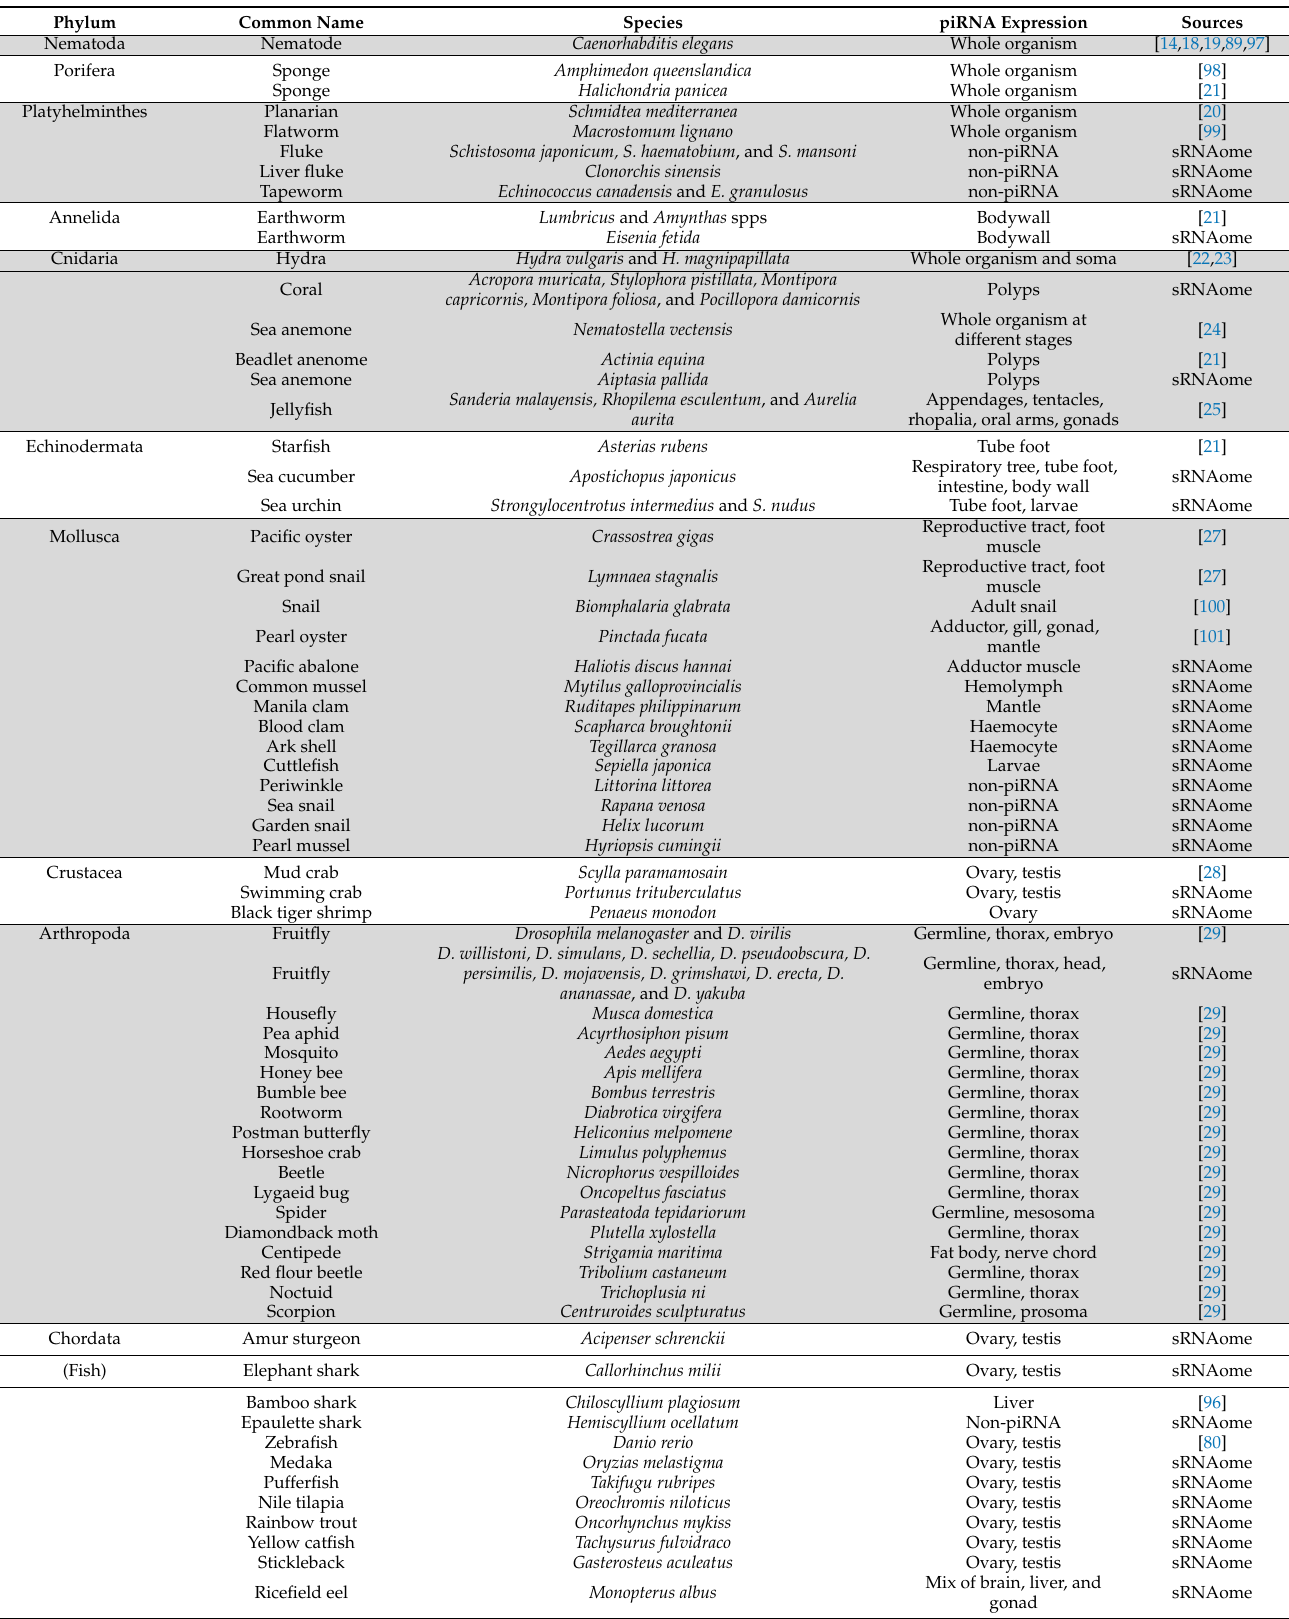
Table 1. Discovery of piRNAs by sRNA-seq in